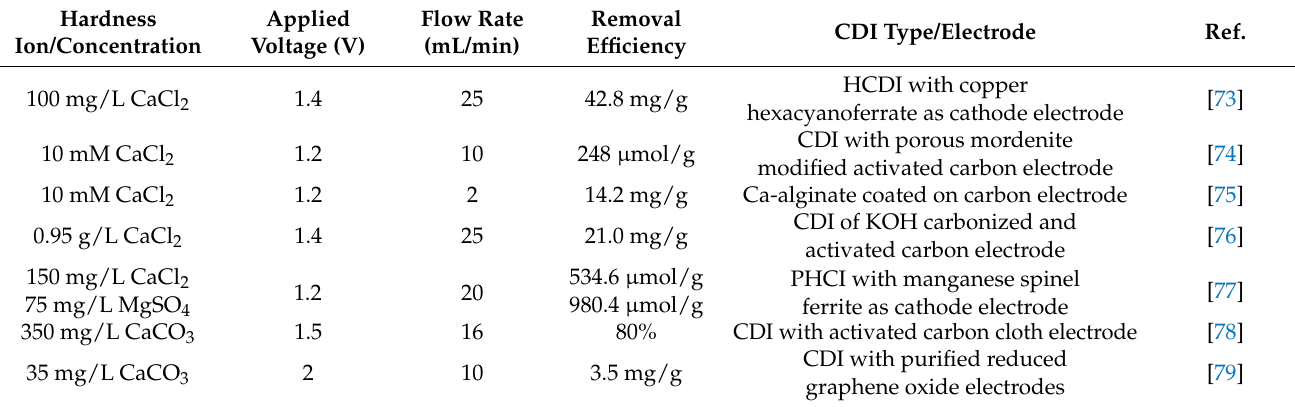
Table 1. Removal efficiency of hardness ions by